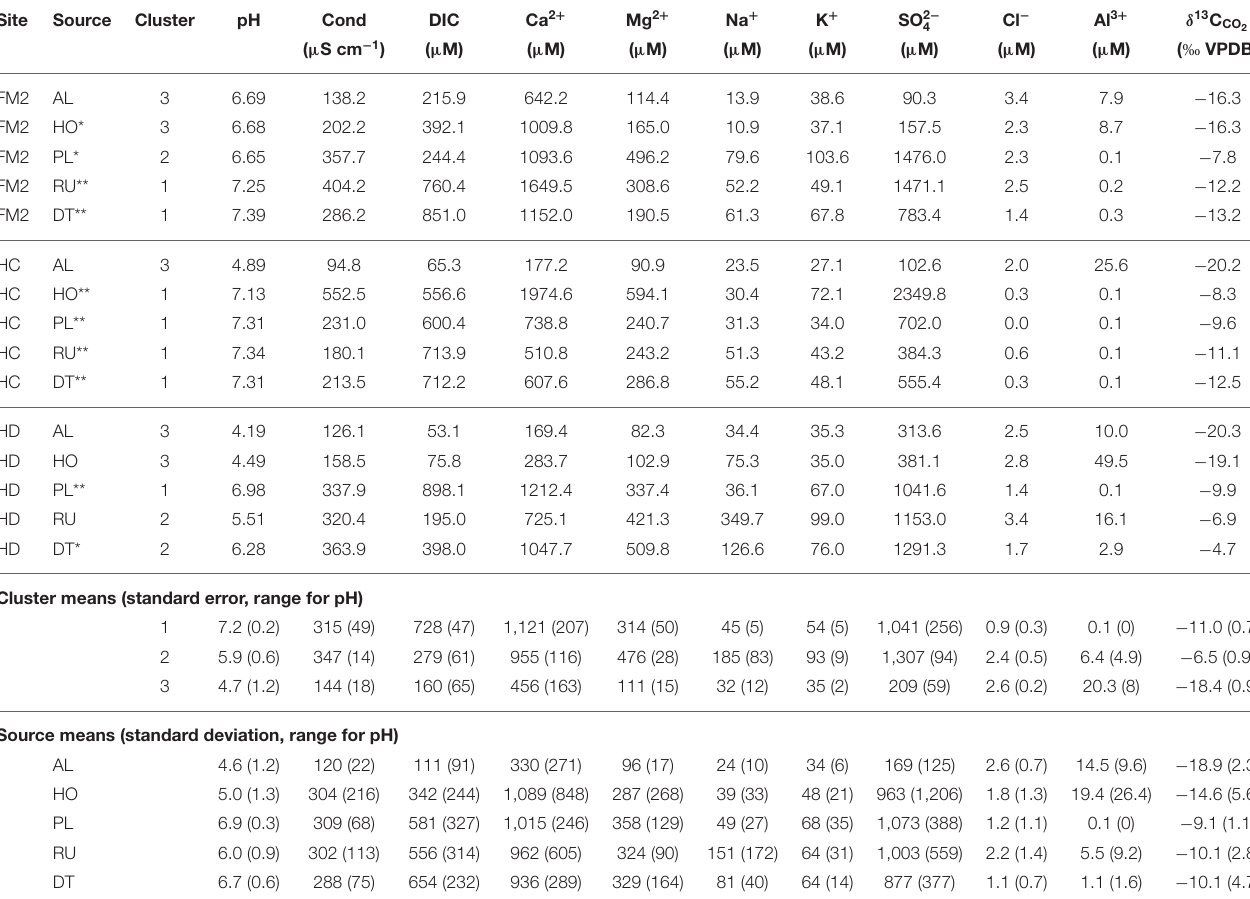
TABLE 4 | Measurements of water chemistry from the mineral weathering experiment at 168h. Site Source